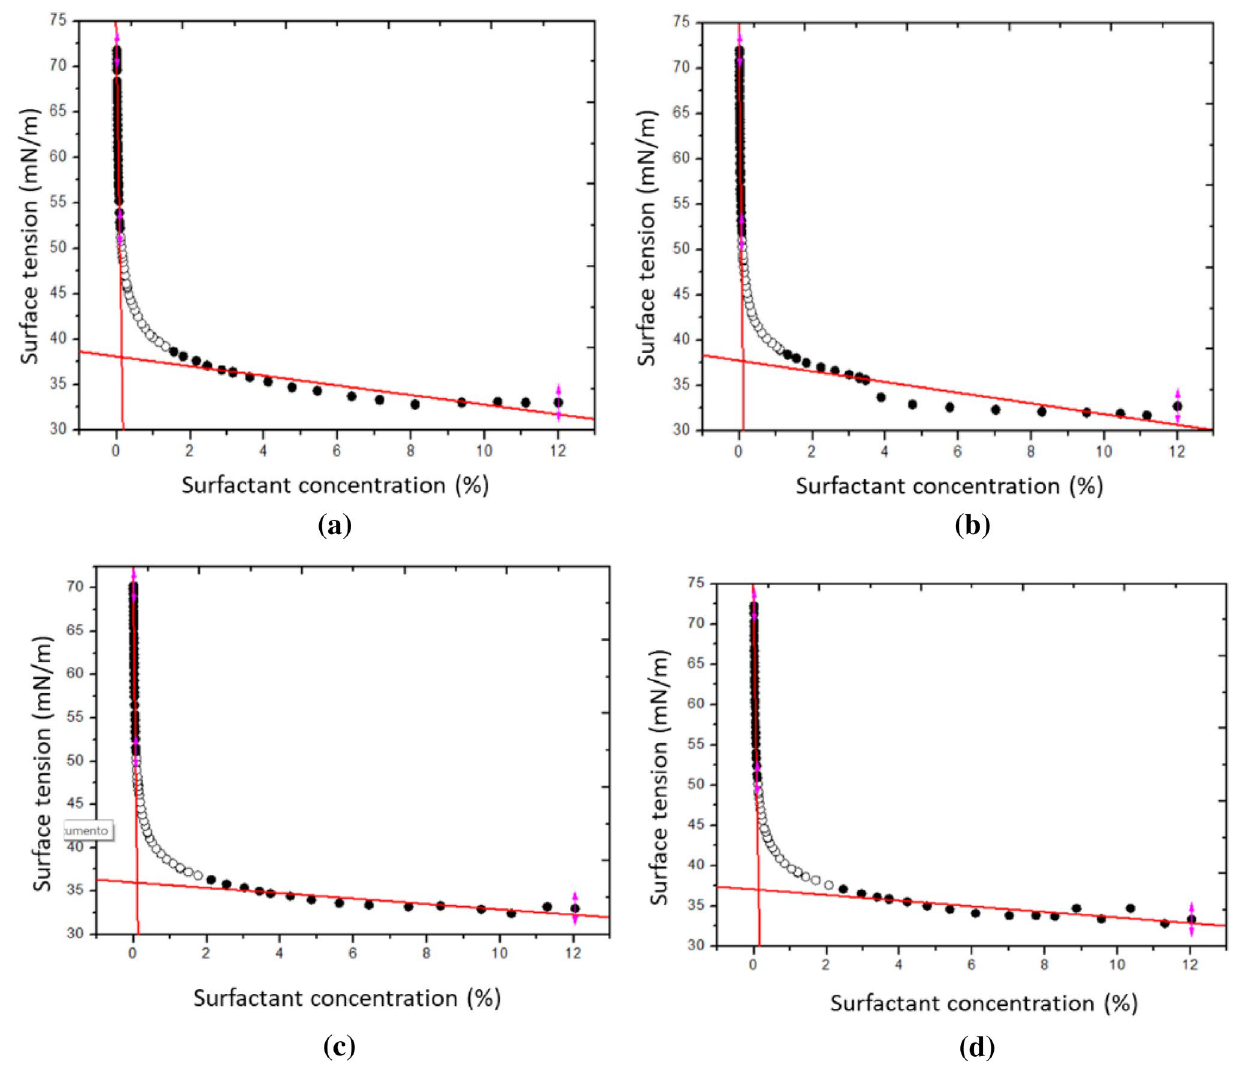
Fig. 3 Curves of surface tension versus surfactant concentration for the microemulsions in acid concentrations of a 1.5%, b 5%, c 10%, and d